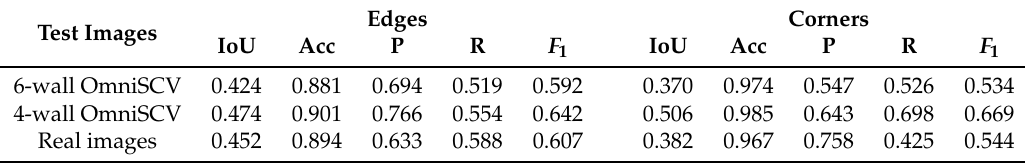
Table 6. Comparative of results of images from different datasets. OmniSCV contains the images created with our tool on a 6-wall room and a 4-wall room. The real images have been obtained from the test dataset of